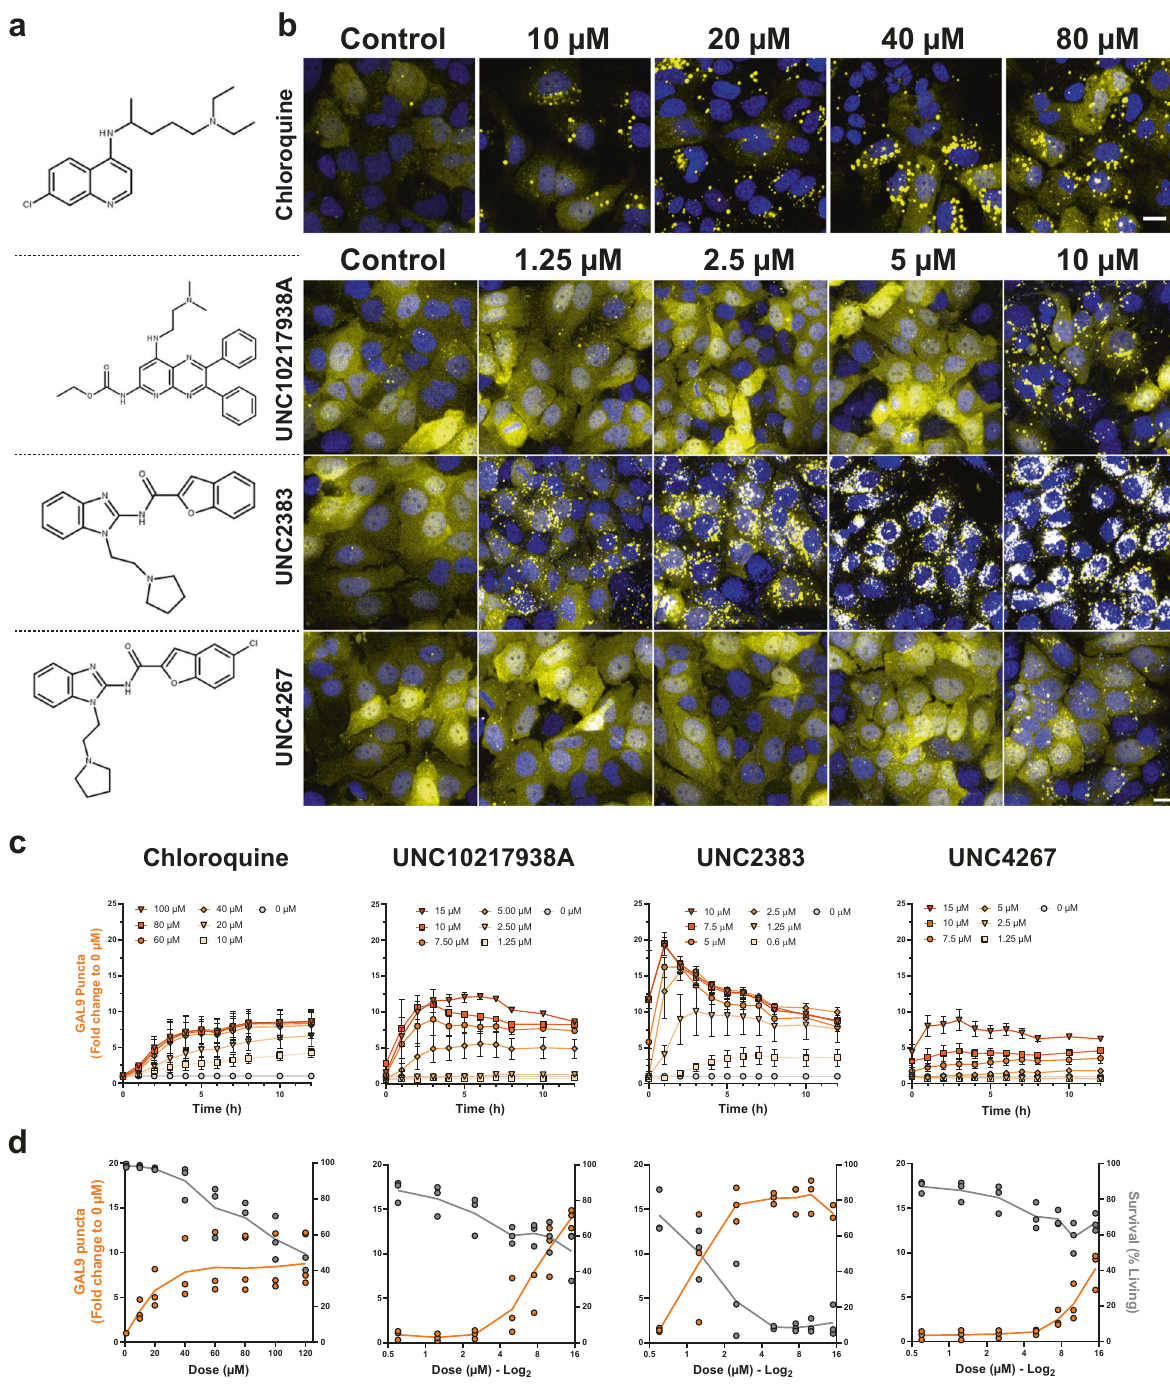
Fig. 2 Small Molecules induce mCherry-GAL9 recruitment. a Chemical structures of chloroquine and UNC compounds b Representative images of Huh7 mCherry-GAL9 cells following 2 h incubation with indicated small molecules and doses, scale bar = 20 µ m. c Kinetic analysis of mCherry-GAL9 puncta formed across 0 – 12 h of incubation with indicated compounds and doses, values represent normalised means ± SEM from n = 3 independent experiments. d Comparison of mCherry-GAL9 puncta induced (Orange line - 8 h chloroquine, 2 h UNC compounds) to cell survival (Grey line - 12 h post-dosing, determined by Hoechst morphology) relative to the compound dose in Huh7 mCherry-GAL9 cells. Lines represent mean values from n = 3 independent